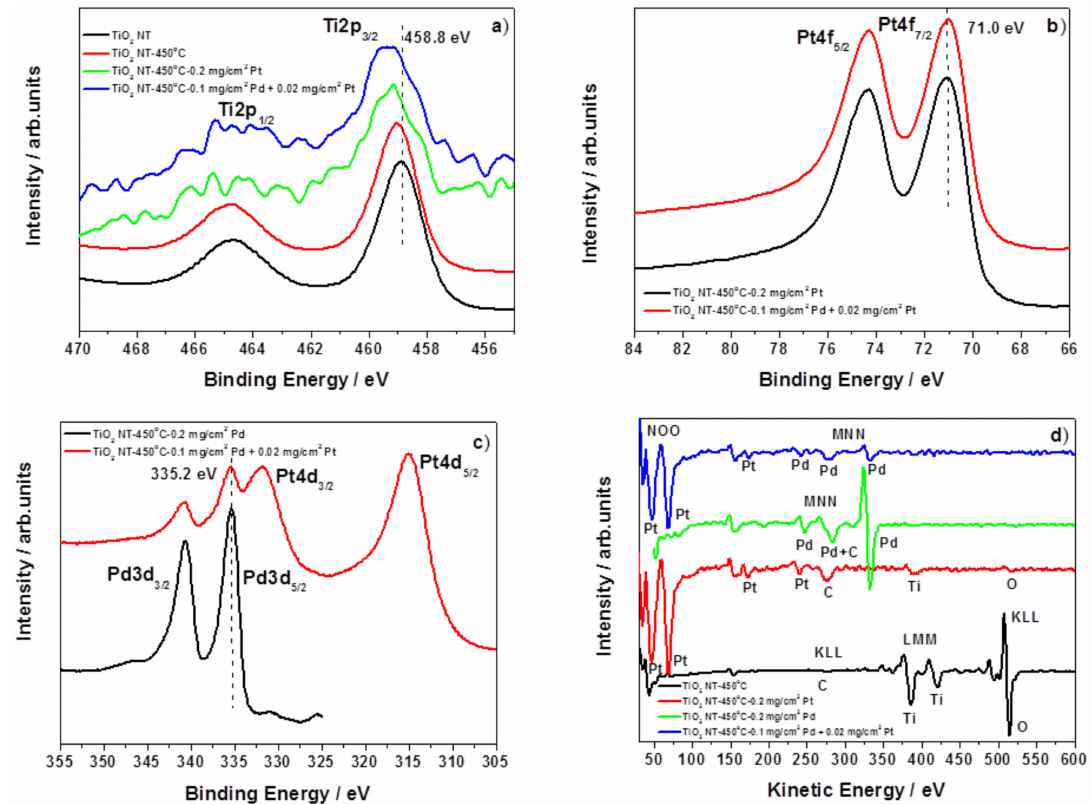
Figure 5. High resolution XPS spectra of Ti2p ( a ), Pt4f ( b ), Pd3d ( c ) regions and AES survey spectra ( d ) registered on the surface: TiO 2 NT 25 V (as-received), TiO 2 NT 25 V / 450 ◦ C − 1h, TiO 2 NT 25 V / 450 ◦ C − 1h + 0.2 mg cm − 2 Pt, TiO / 450 ◦ C − 1h + 0.2 mg c 2–2 Pd, TiO / 450 ◦ C − 1h + 0.1 2 NT 25 V 2 NT 25 V mg cm − 2 Pd + 0.02 mg cm − 2